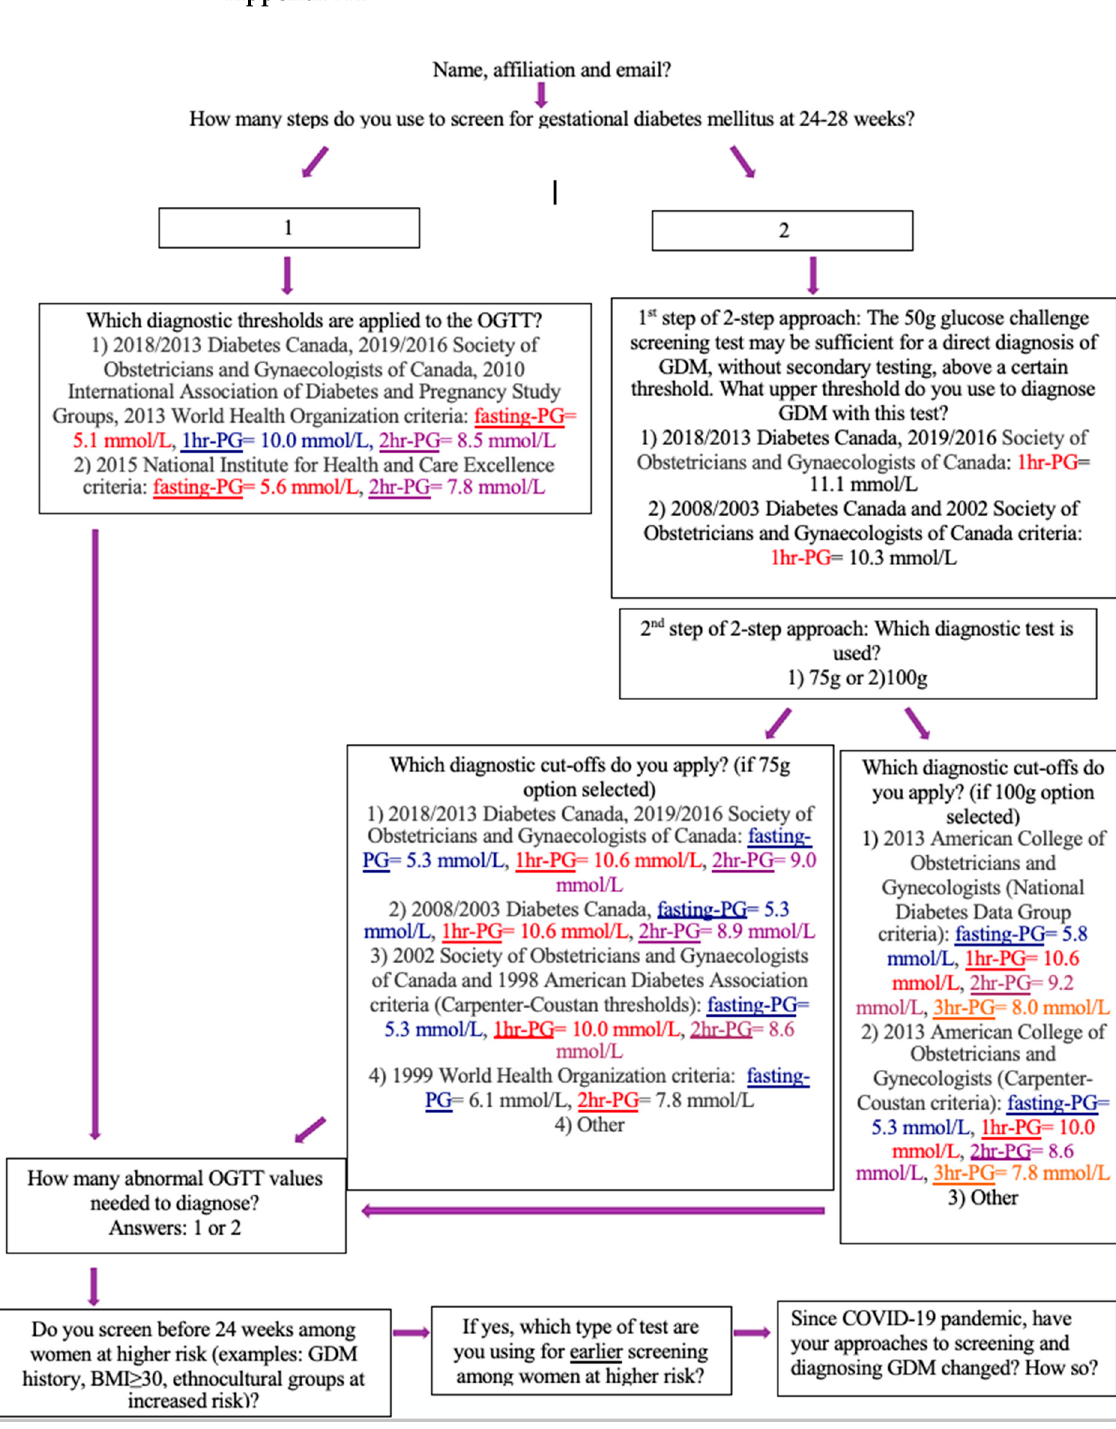
Figure A1. Contents of voluntary, online survey distributed to CanDIPS members.